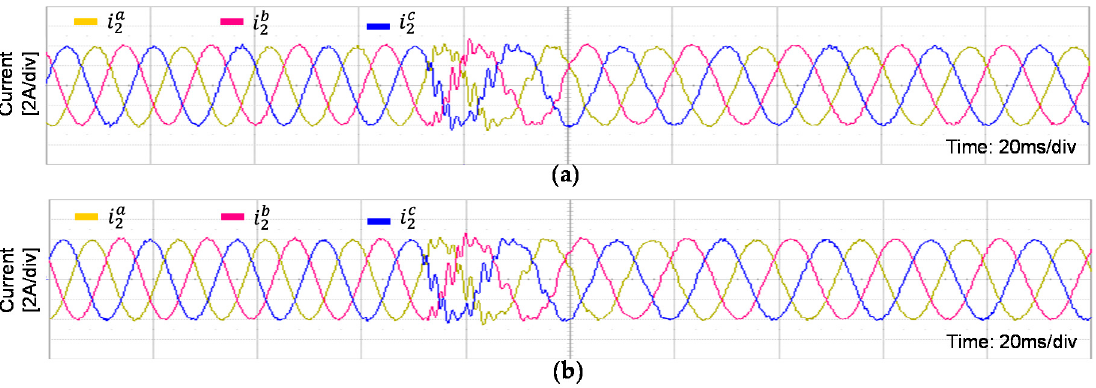
Figure 23. Experimental results for the proposed control method under the grid frequency change from 60 Hz to 50 Hz. ( a ) Three-phase grid currents under distorted grid; ( b ) three-phase grid currents under distorted and imbalanced grid voltages with 𝑒 (cid:3028) drop to 83.33% of the nominal value.